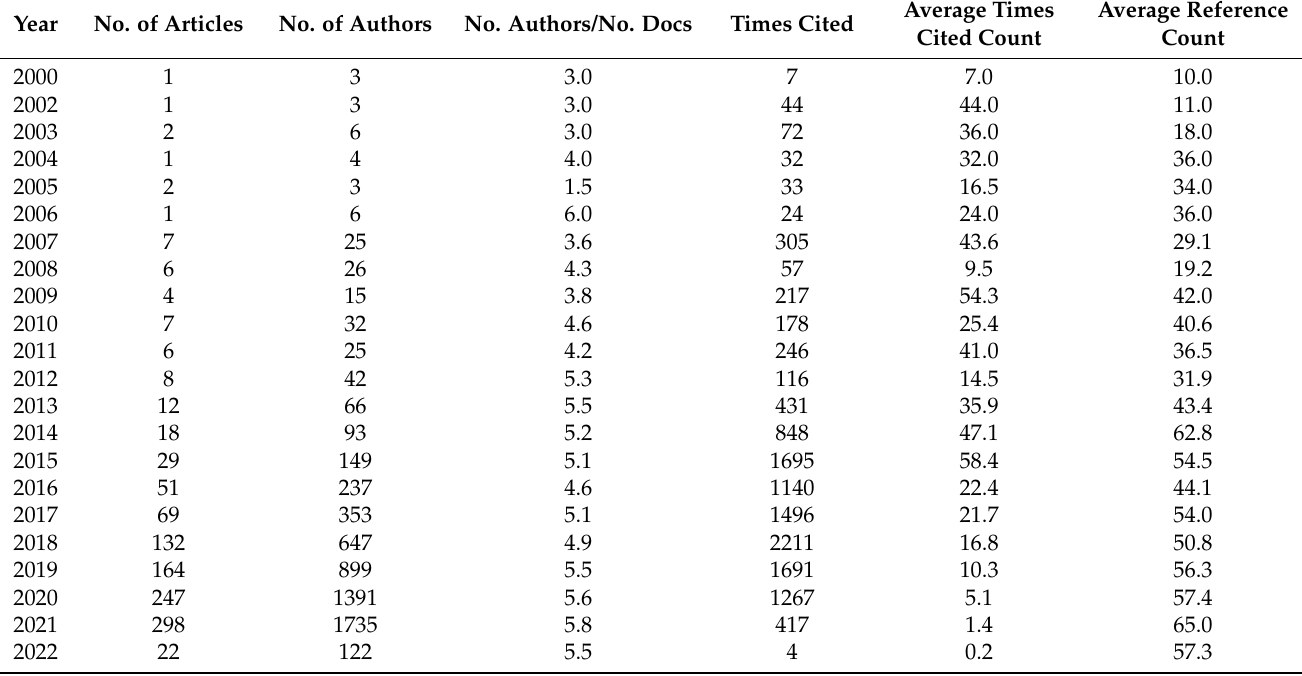
Table 1. Quantitative analysis of the trend of research on